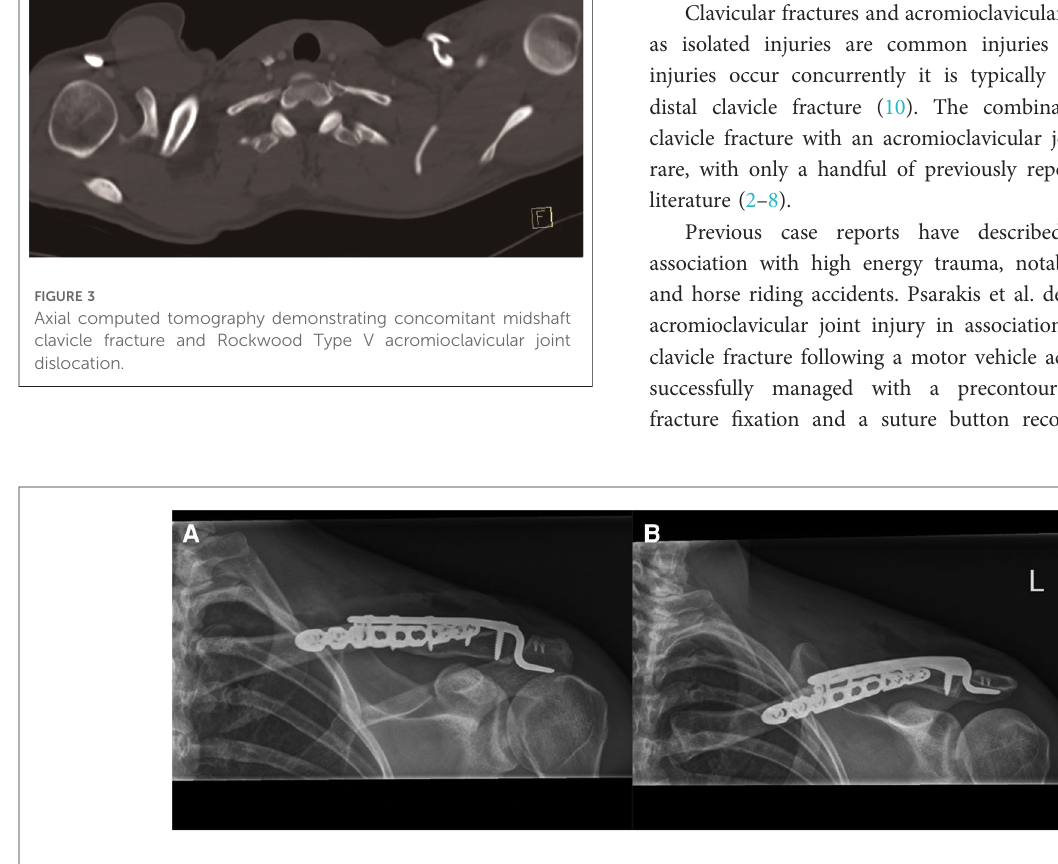
FIGURE 4 Radiographs demonstrating fi xation of the fracture and dislocation with a hook plate and anterior clavicle